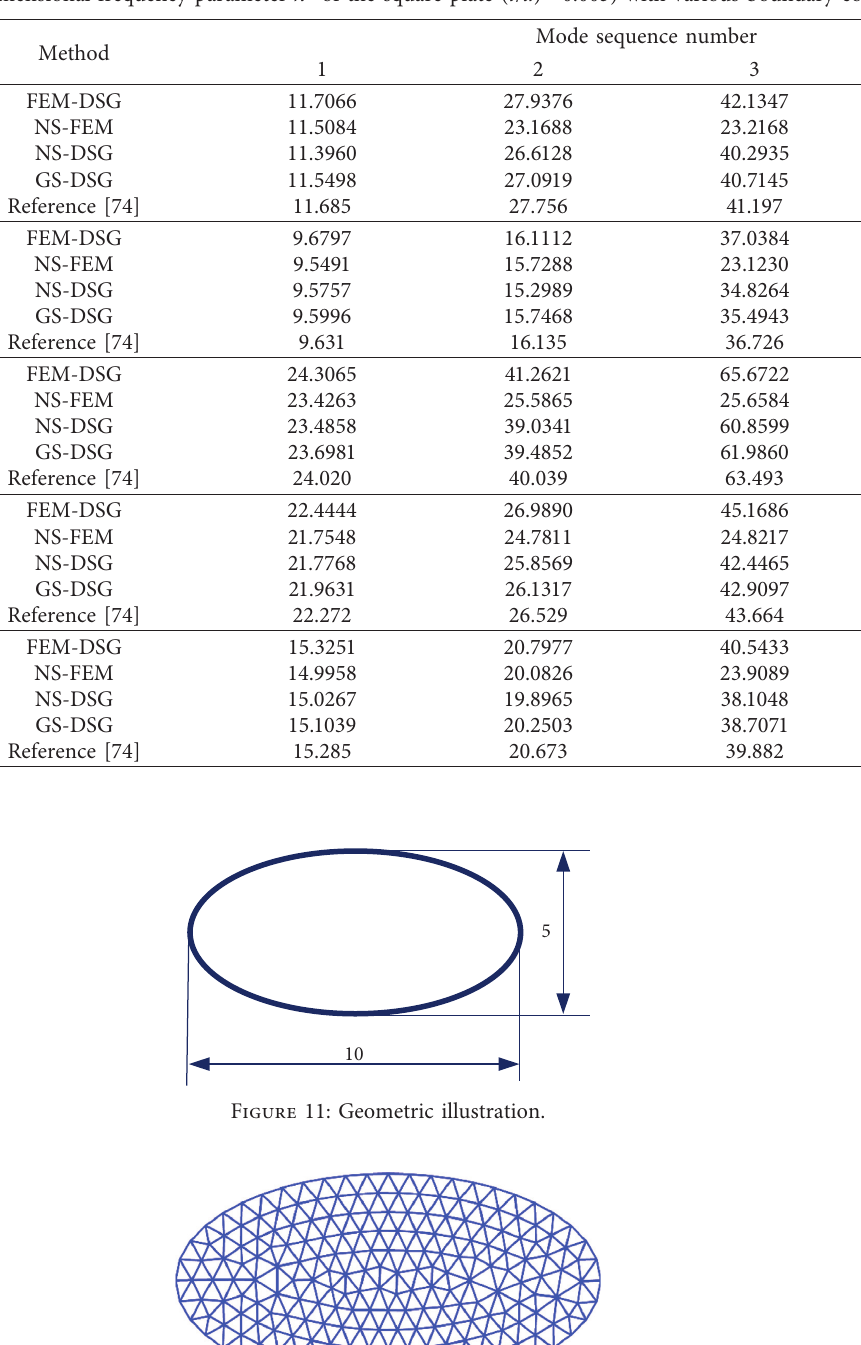
Table 6: A nondimensional frequency parameter λ 2 of the square plate ( t / a ) � 0.005) with various boundary conditions.